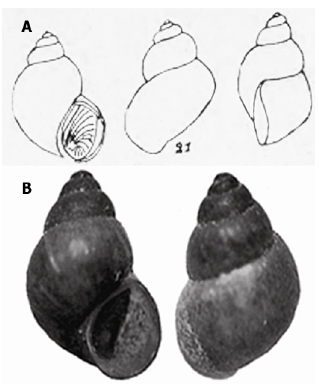
Fig. 1. ‟ Littoridina” santiagensis Biese, 1944. A . The only drawings of a specimen of the species taken from the original description by Biese (1944). B . Lectotype housed at the Museo Nacional de Historia Natural, Santiago, Chile (MNHNCL) (after Collado et al.